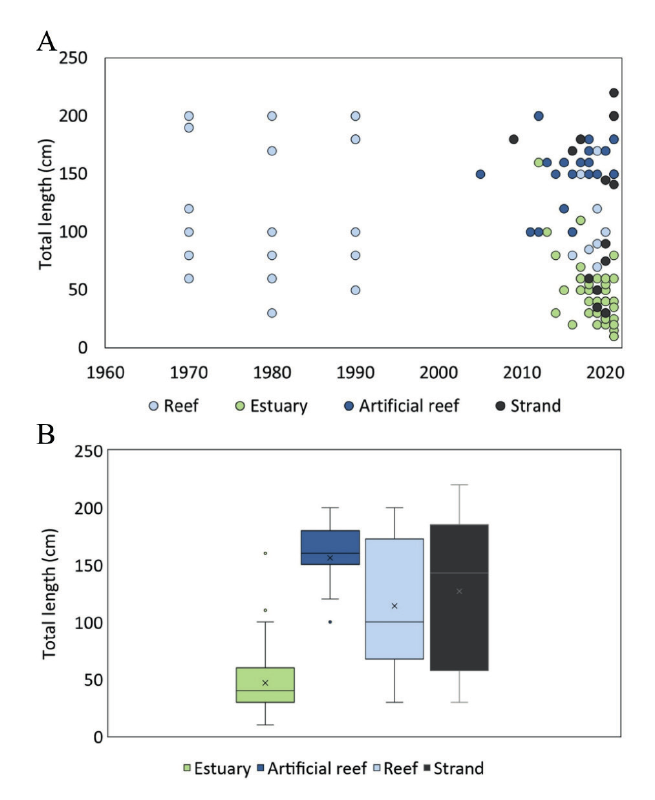
FIGURE 5 | A. Sightings of individuals of Atlantic Goliath Grouper (AGG) Epinephelus itajara in Alagoas, between 1960 and 2021, arranged by habitat and; B. Distribution of AGG with estimated Total Length arranged by habitat. Stranded animals also make up the boxplot. Habitats are separated by color, boxplots presents the maximum and minimum limits (upper and lower rush). In the interquartile range are the third and first quartiles at the ends, median and mean (x) of the AGG total